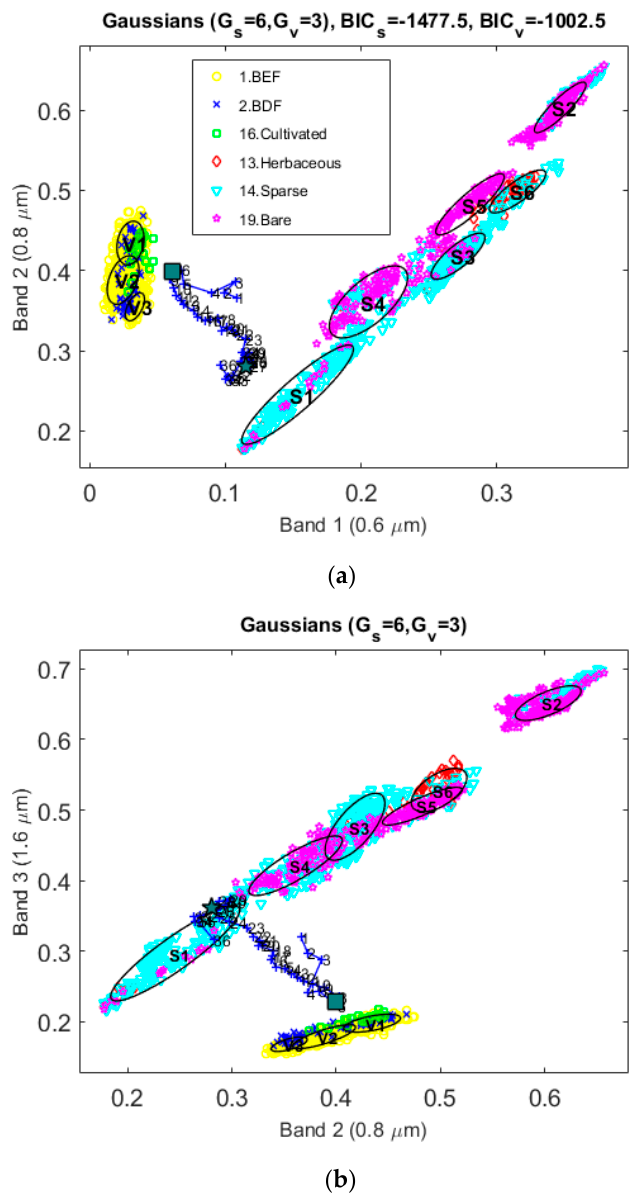
Figure 4. Illustration of the probabilistic mixing model concept over in the k 0 space of SEVIRI channels: ( a ) channel 1 and 2; ( b ) channel 2 and 3. Elliptical probability density contours associated with clusters (from V 1 to V 3 for vegetation and from S 1 to S 6 for soil). BDF and BEF correspond to broadleaved deciduous and broadleaved evergreen forest, respectively. BIC s and BIC v refer to the values of BIC for the soil and vegetation mixture models,